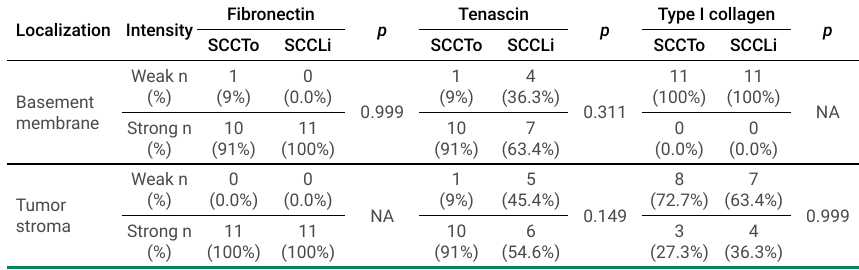
Table 3. Distribution of percentages of the intensity of fibronectin, tenascin and type I collagen in SCCTo and SCCLi, according localization. Localization